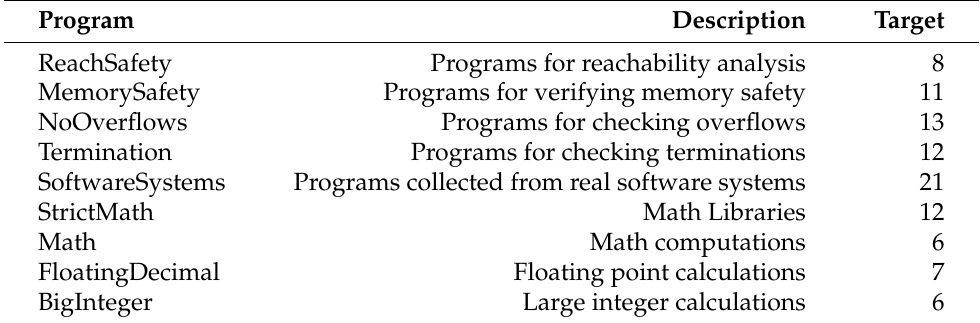
Table 2. Benchmarks used in the